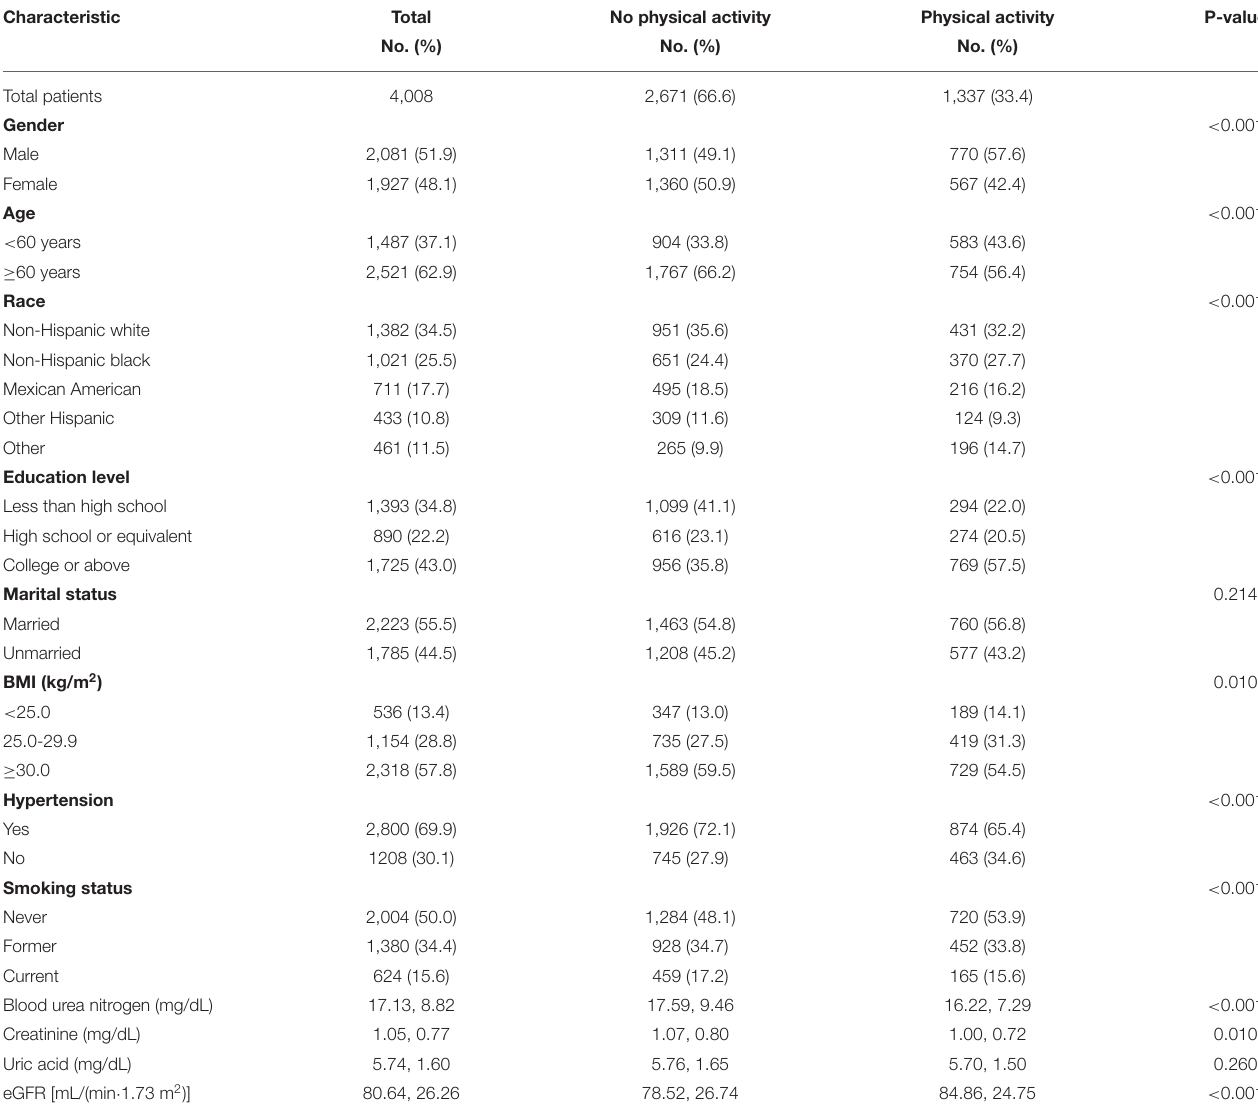
TABLE 2 | Baseline characteristics of diabetes participants between 2007 and 2018 based on physical activity status.